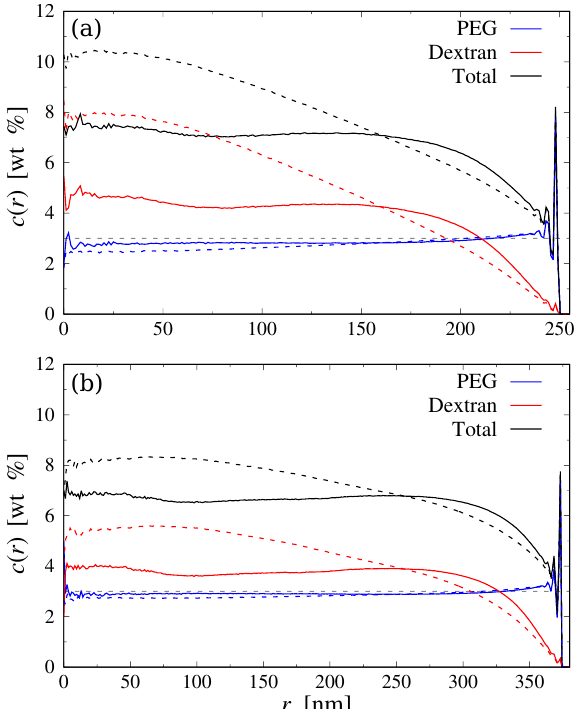
Figure 4. Radial monomer concentration profiles for droplets with ( a ) R ≈ 260nm and ( b ) R ≈ 380nm. Solid and dashed lines show simulation results for monodisperse and polydis- perse Dextran chains, respectively. The horizontal dashed grey line indicates the average polymer concentration of each species